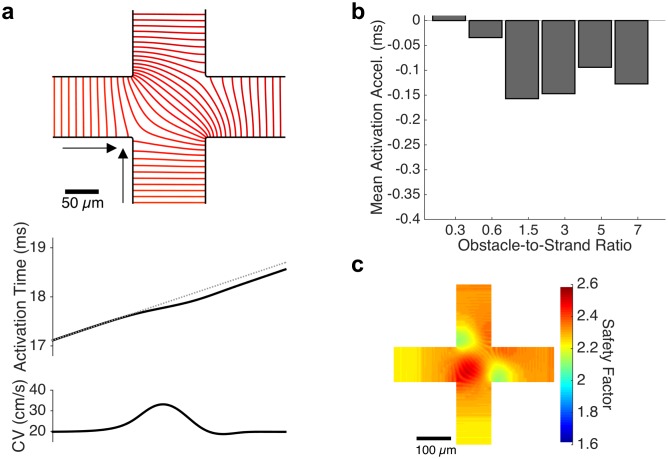
Conduction acceleration due to wavefront collision.(a) At intersection points along the diagonal axes, the simultaneous arrival of two wavefronts leads to a non-annihilating wavefront collision that causes a local increase in conduction velocity. This local speeding, up to 67.3% In tissues with an obstacle-to-strand ratio of 5, leads to an acceleration of activation across the intersection site. (b) The magnitude of acceleration is approximately 0.15 ms for all obstacle-to-strand ratios above 1.5. (c) The safety factor of conduction rises sharply at the site of wavefront collision at the center of the intersection; reduced safety factor is observed near the corners of the intersection.